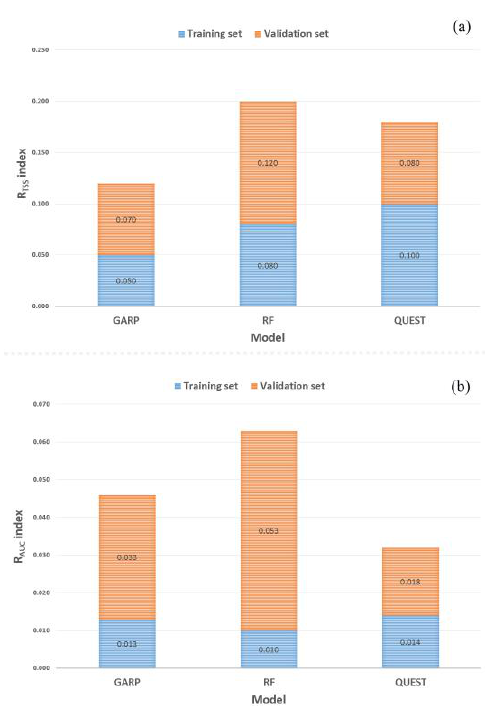
Figure 9. Robustness of the three models in the training and validation steps, based on two evaluation criteria: ( a ) true skill statistic (TSS) and ( b ) area under the receiver operating characteristic curve (AUC).